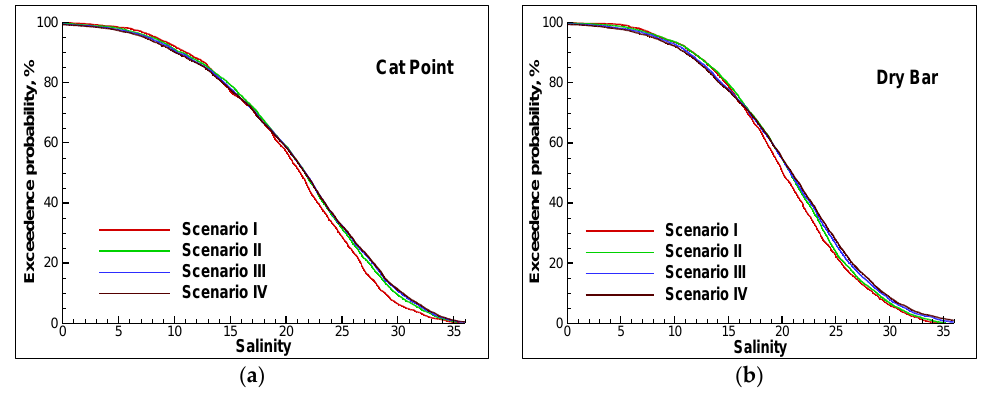
Figure 8. Exceedance rate of daily average salinity at ( a ) Cat Point; and ( b ) Dry Bar stations. Scenarios I–IV.